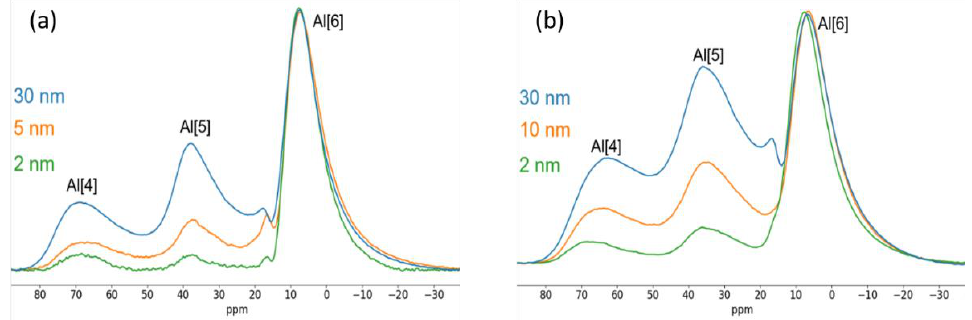
Figure 12. 27 Al NMR spectra of ( a ) Al 2 O 3 , deposited on CA and ( b ) Al 2 O 3 infiltrated into